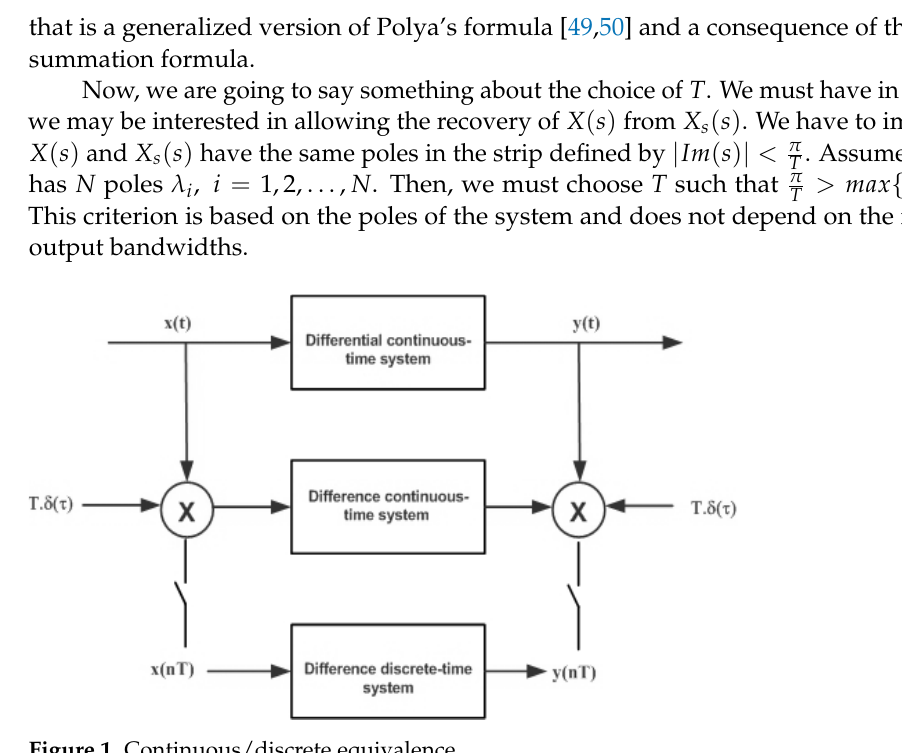
Figure 1. Continuous/discrete